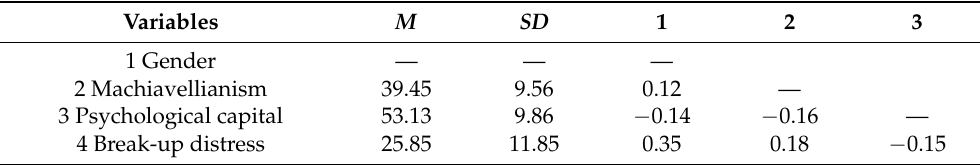
Table 1. Descriptive statistics and correlation analysis.